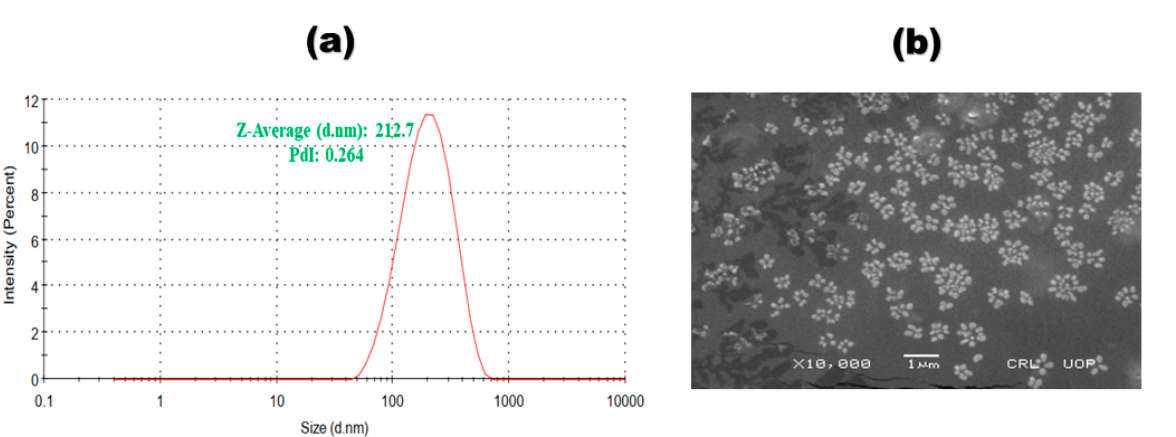
Figure 3. ( a ) Particle size and PDI and ( b ) SEM image of drug-loaded formulation.